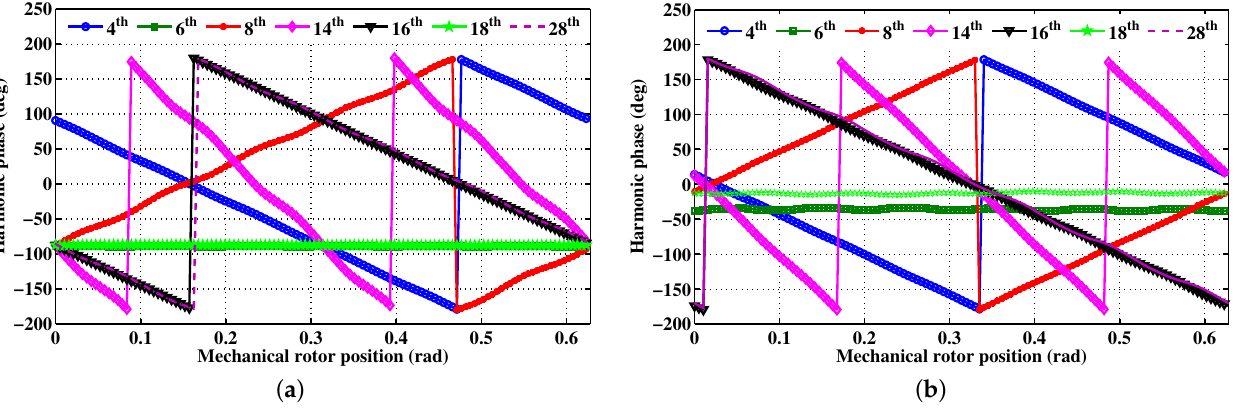
Figure 11. Spectrum of the spatial repartition of the analytically-predicted flux density at θ r = 0 ◦ . ( a ) Flux density created by the PMs, ( b ) armature magnetic reaction.